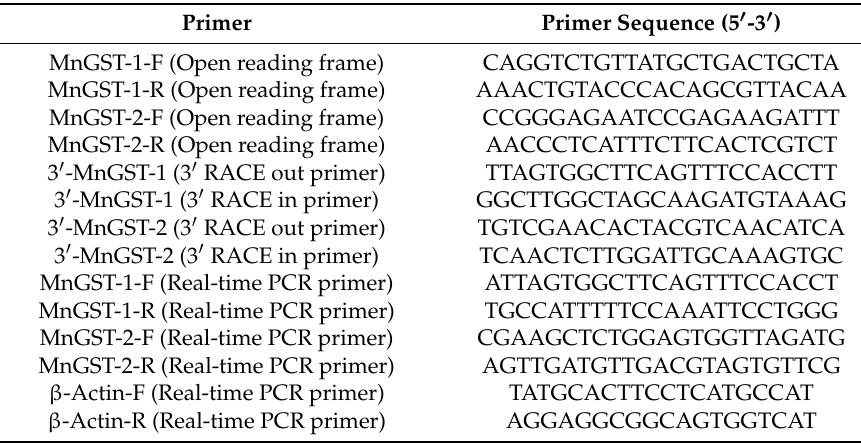
Table 1. List of primers used in this study.